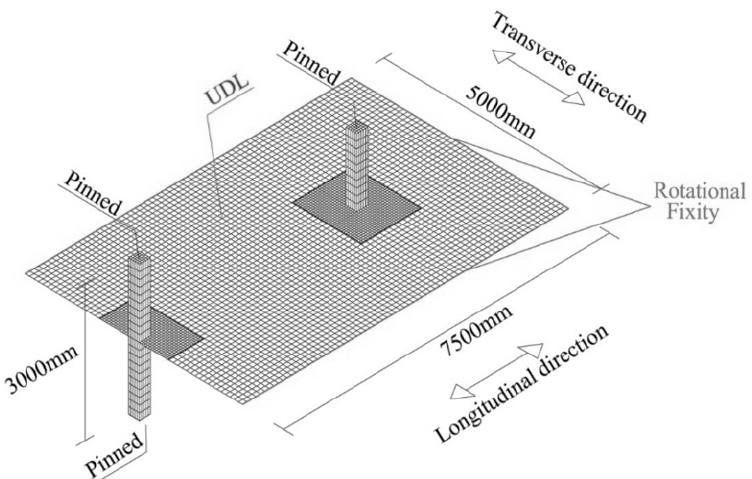
Figure 5. Mesh used for the NLFEA of Sherif and Dilger’s [ 6] tests.